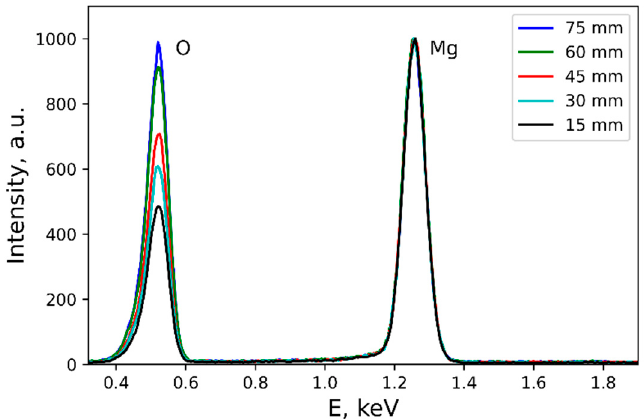
Figure 2. The EDX spectra registered at different positions (indicated in the legend) along the 80 mm long superhydrophobic substrate S4.